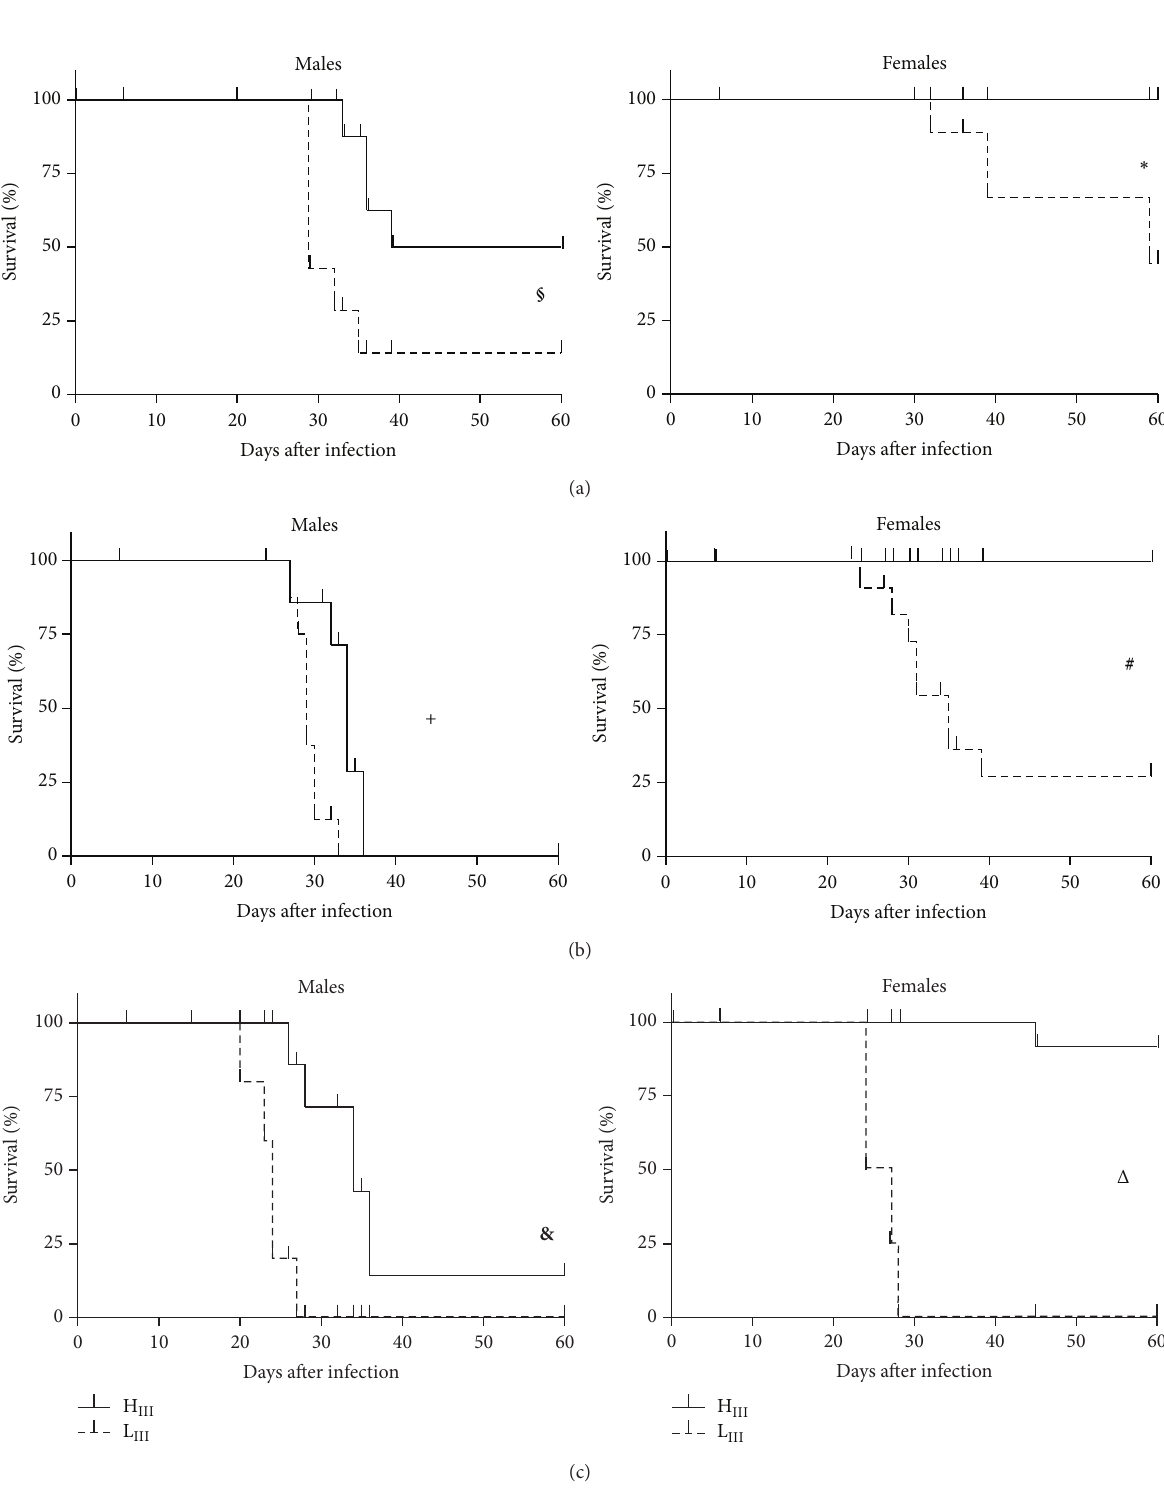
(b), or 10 4 (c) of CL strain trypomastigote forms. Interline differences evaluated by survival curve analyses of each group ( 𝑛 = 8 ) are indicated for males ( § 𝑃 = 0.018 ; + 𝑃 = 0.05 ; & 𝑃 = 0.008 ) and females ( ∗ 𝑃 = 0.015 ; # 𝑃 = 0.0008 ; Δ 𝑃 < 0.0001